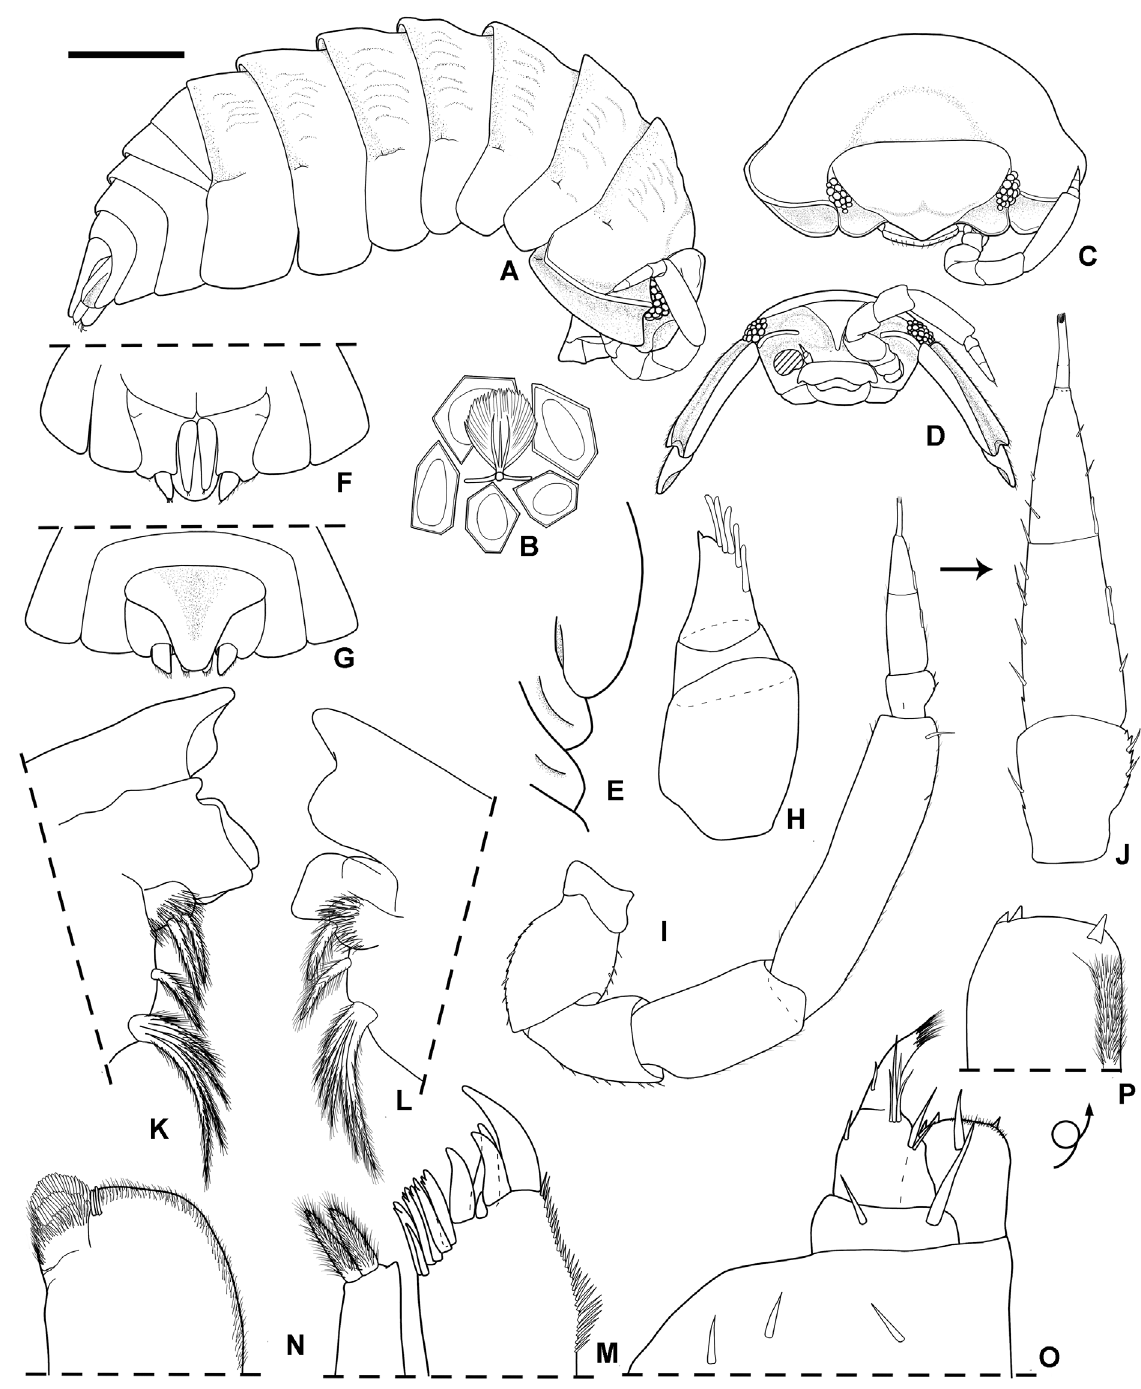
Fig. 5. Brasiloniscus littoralis gen. et sp. nov., paratype, ♂ (MZUSP 36182). A . Habitus, lateral view. B . Dorsal scale-setae. C . Cephalon and pereonite 1, dorsal view. D . Cephalon, frontal view. E . Pereonites 1–3, ventral view. F . Pleonites 4 and 5, telson and uropods, ventral view. G . Pleonites 4 and 5, telson and uropods, dorsal view. H . Antennula. I . Antenna. J . Antennal flagellum. K . Left mandible. L . Right mandible. M . Maxillula. N . Maxilla. O . Maxilliped. P . Maxilliped endite. Scale bar: 1